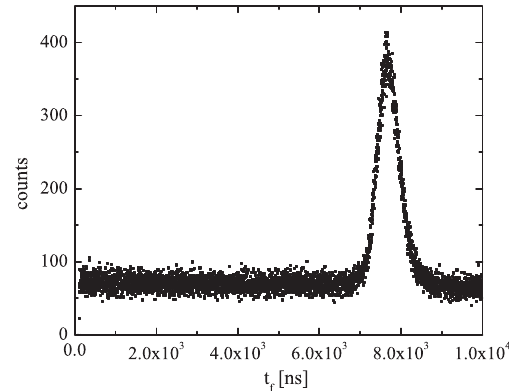
Figure 7. TOF spectrum of 500eV protons. The delay between the pulses applied to the BN gates is 3 . 3 µ s, while the delay t f between the pulse to BNG1 and the detected signal is 7 . 2 µ